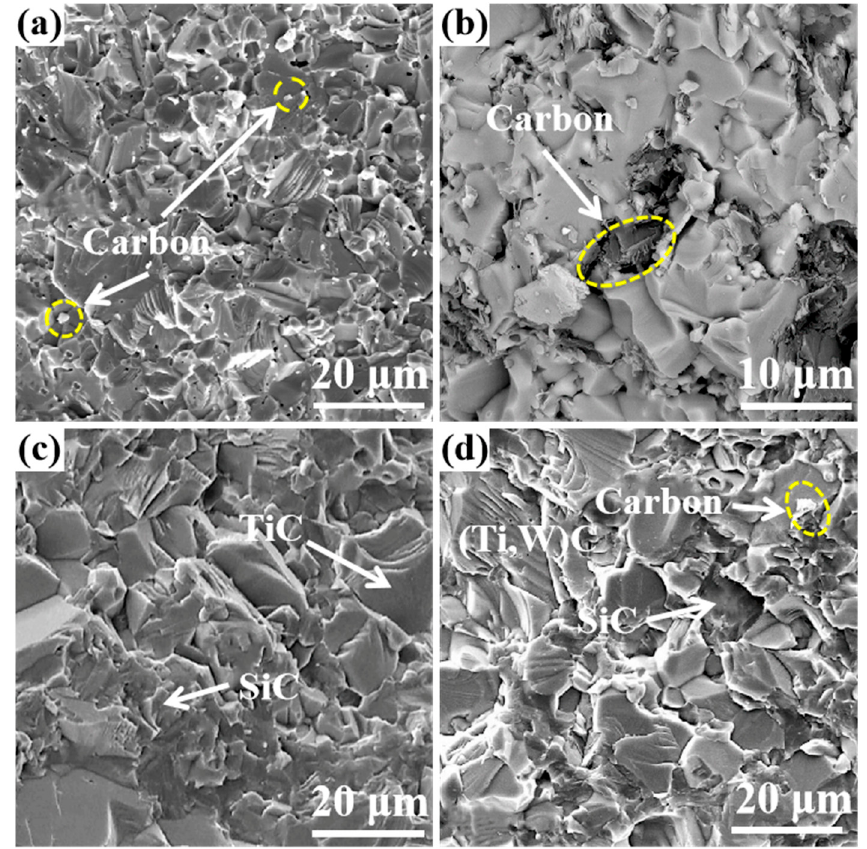
Figure 5. SEM images of Particle reinforced TiC Composites ( a ) TiC-WC, ( b ) TiC-C, ( c ) TiC-SiC, ( d ) TiC-SiC-WC.